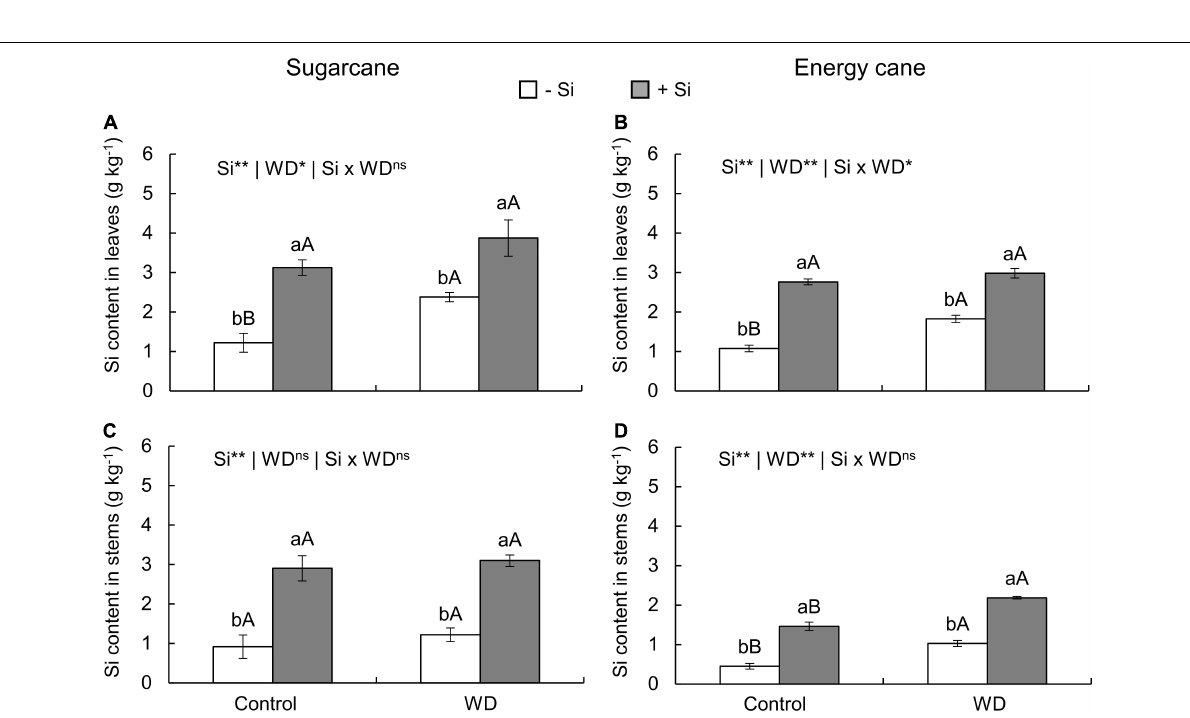
Frontiers in Plant Science |